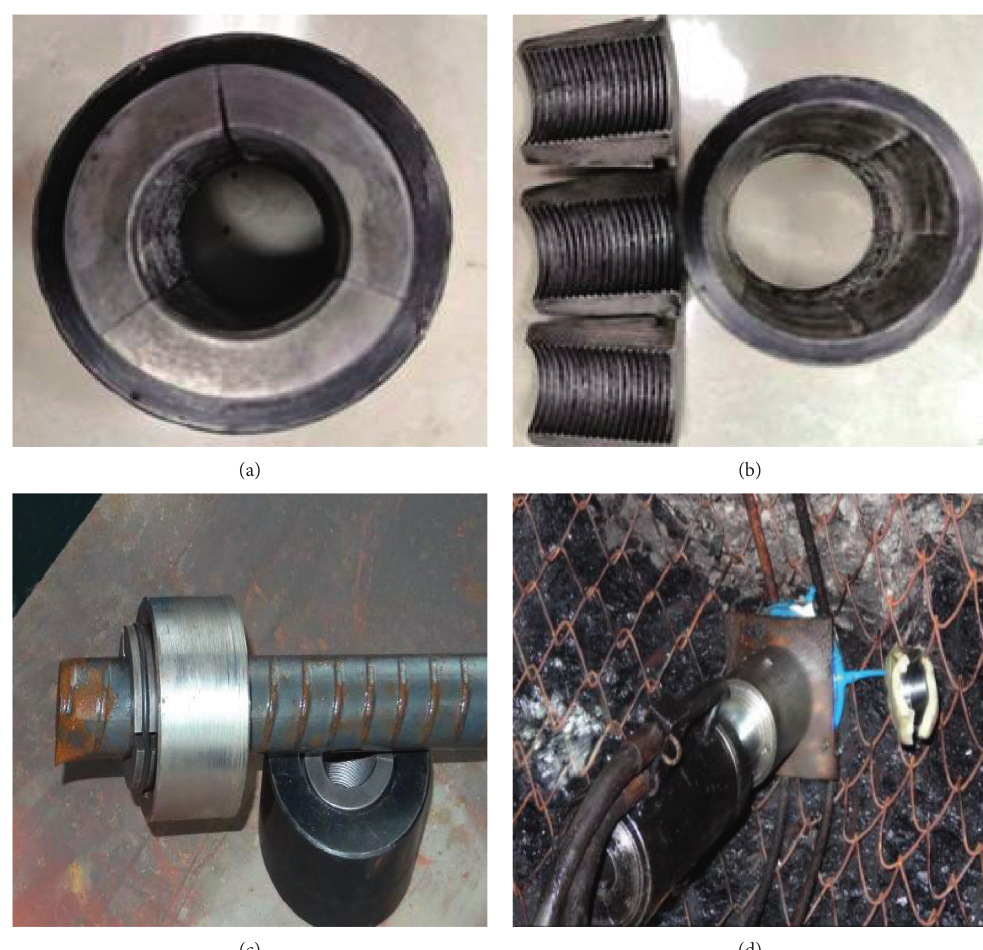
Figure 7: The anchoring system components: (a) barrel and wedge; (b) separated barrel and wedge; (c) barrel and wedge installed in the rock bolt; (d) barrel and wedge installation.